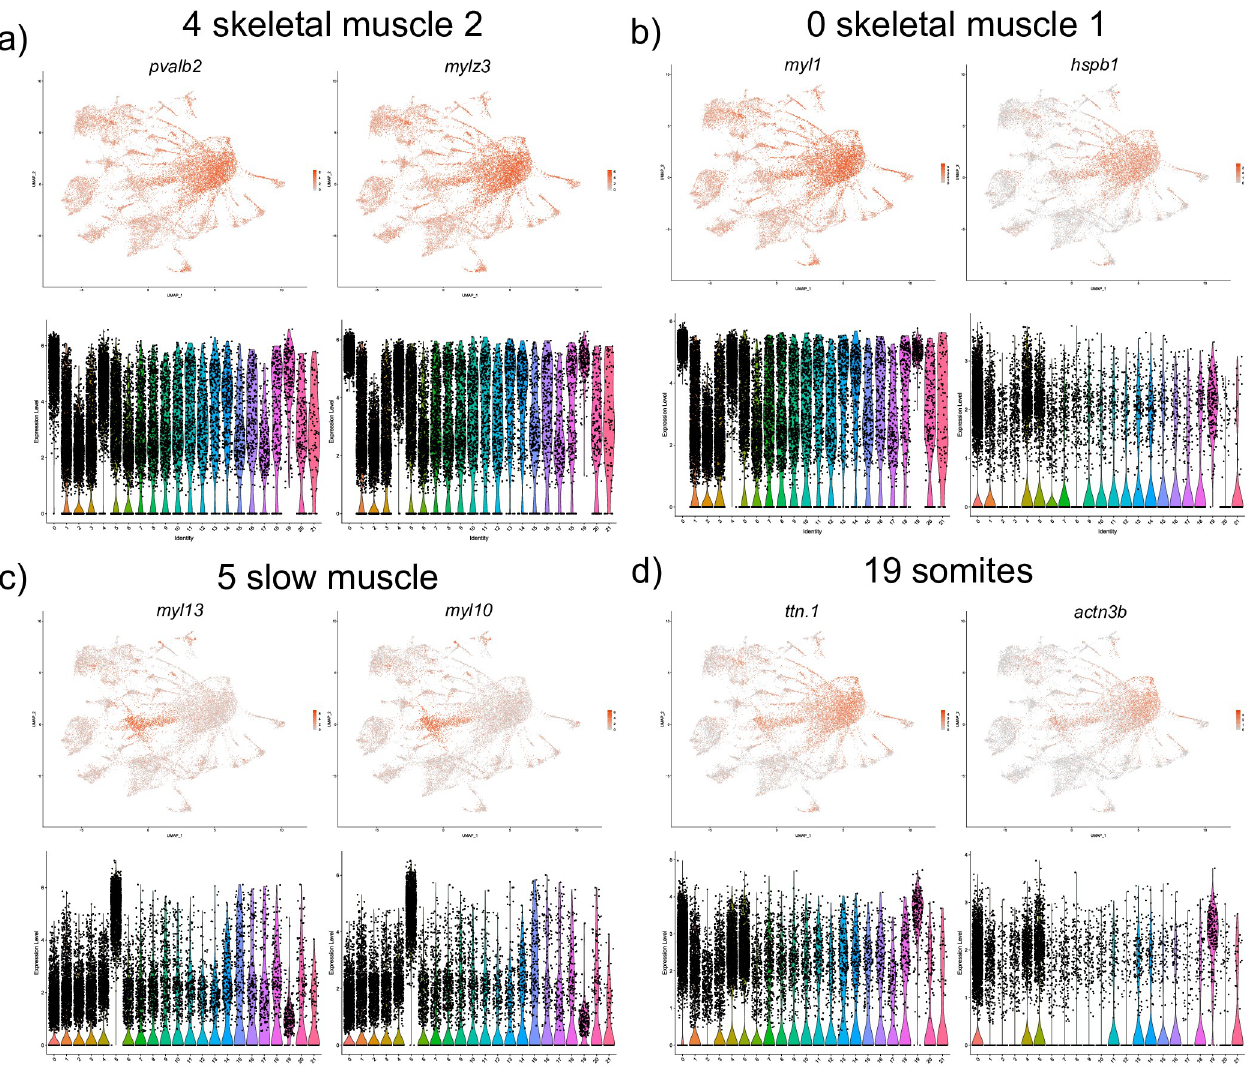
Fig 9. UMAP and violin plots showing the expression of selected marker genes for two skeletal muscle groups (clusters #4 and #0, a,b), slow muscle (cluster #5, c) and somites (cluster #19, d).